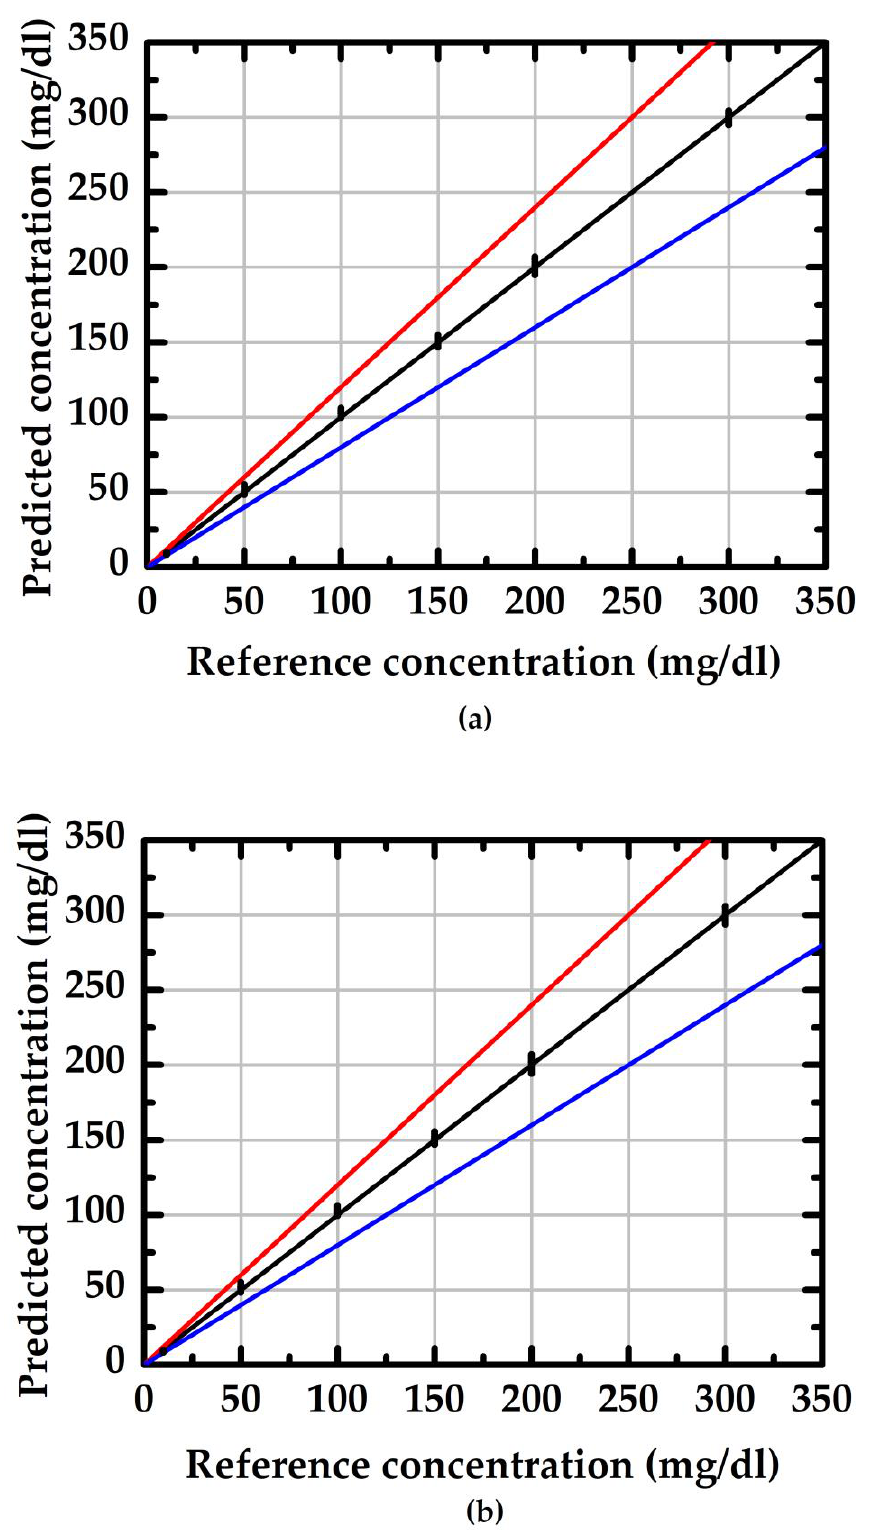
Figure 8. The reliability evaluation of the proposed method with different length of the doped type NWGS. ( a ) nanowire lengths of 3.5 µ m; ( b ) nanowire lengths of 5.3 µ